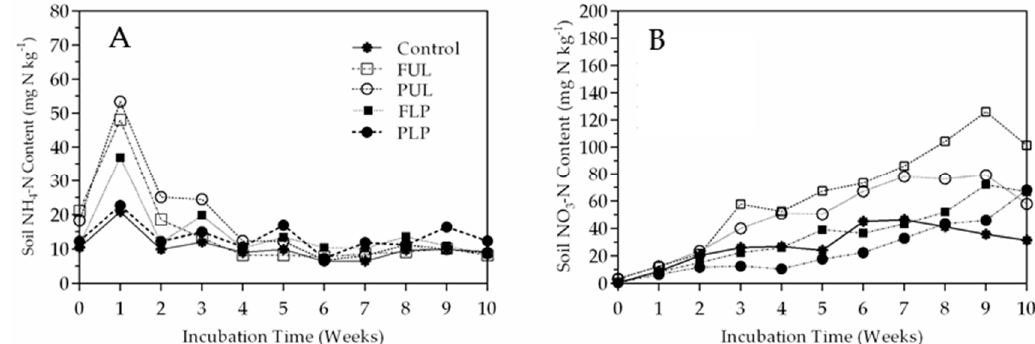
Figure 1. Evolution of the soil NH 4 -N ( A ) and NO 3 -N ( B ) content in the unamended control and surface applications to soil of fine-particle untreated litter (FUL); pelletized untreated litter (PUL); fine-particle low-P treated litter (FLP); and pelletized low-P treated litter (PLP). Each data point is the average of three replicates.